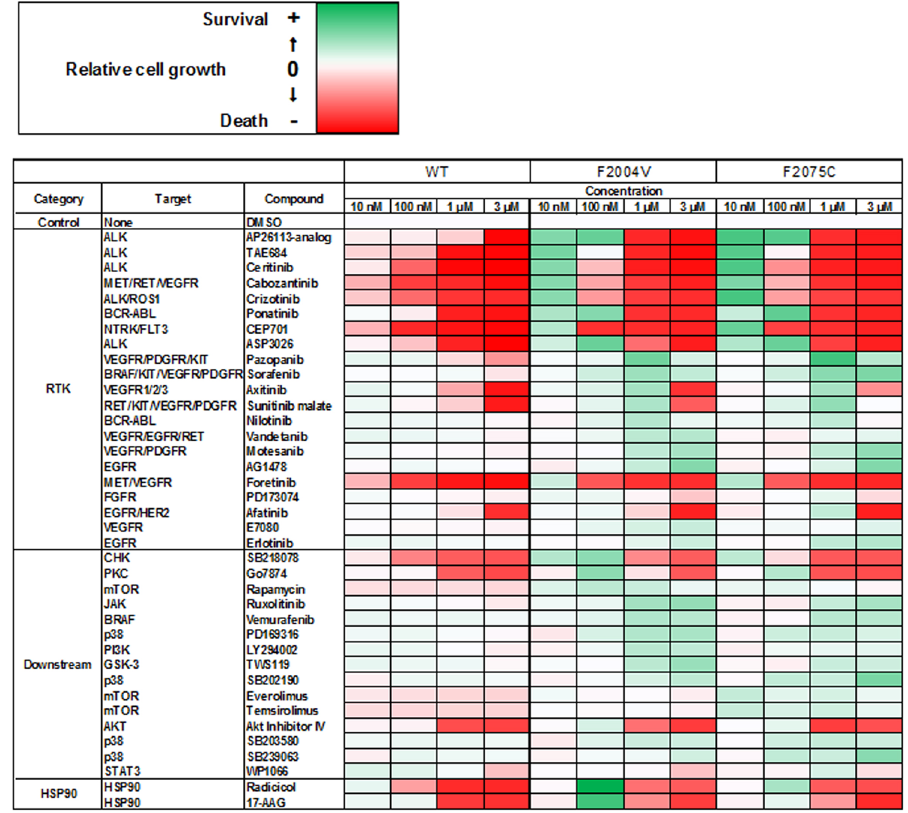
Figure 6. High-throughput inhibitor screening for Ba/F3 cells expressing wild-type CD74-ROS1, F2004V-, or F2075C-mutated CD74-ROS1. Representative data showing cell growth of wild-type CD74-ROS1 (WT), F2004V- or F2075C-mutated cells with treatment by each listed compound with DMSO treatment as control are shown in a heat map (all screening data and detailed values are shown in Supplementary Fig. S7). Red indicates that relative cell growth is suppressed and green that relative cell growth is enhanced compared with DMSO treatment. Cells were treated with 10, 100 nM, 1 or 3 μ M of the indicated compounds for 72 h, then cell viability was measured by the CellTiter-Glo